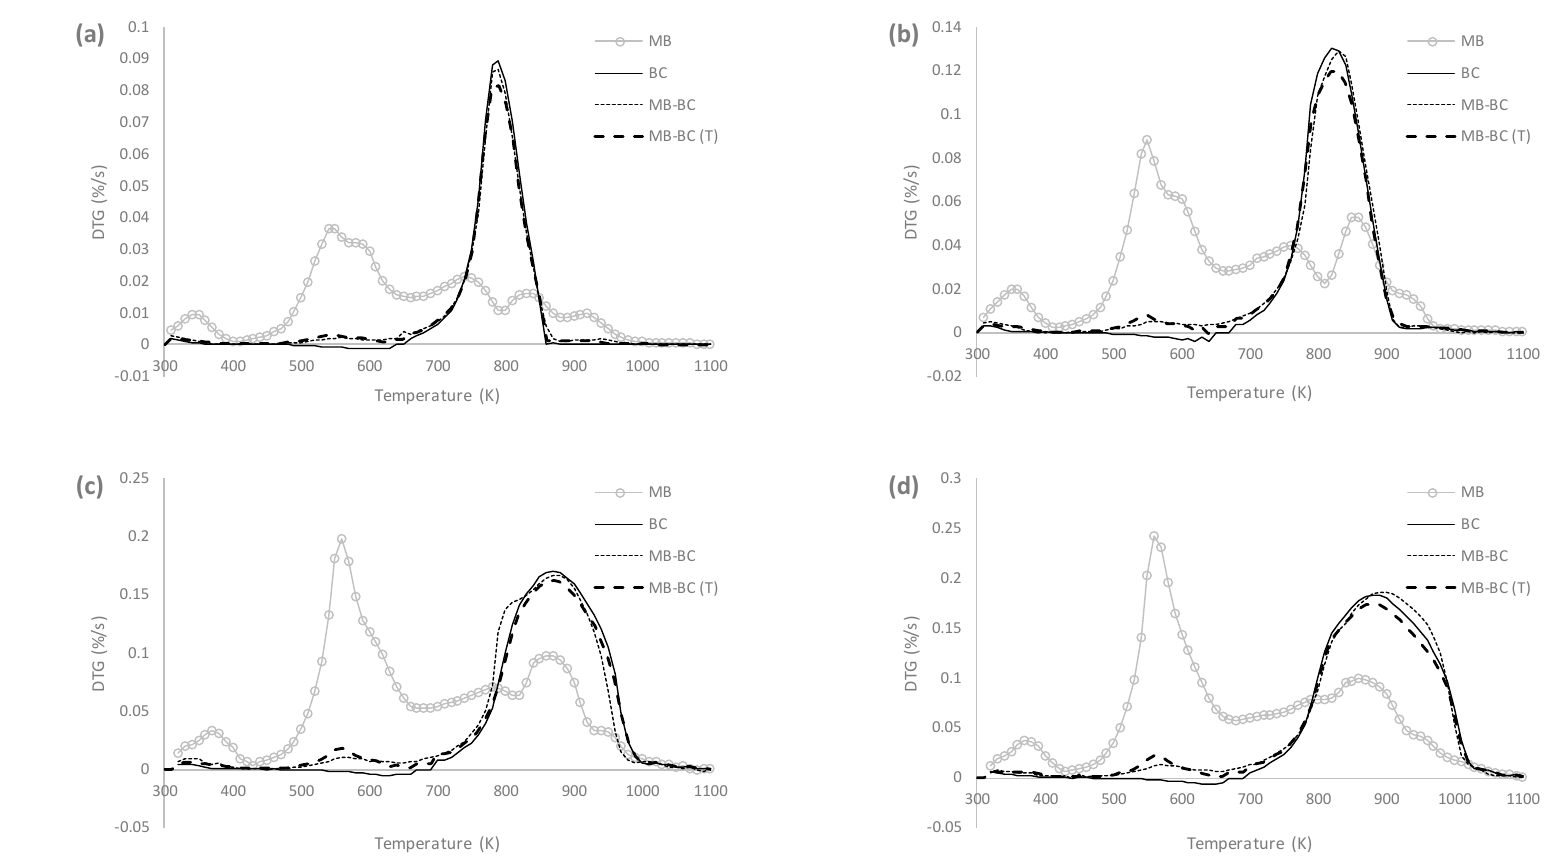
Figure 2. Di ff erential thermogravimetry (DTG) curves corresponding to the temperature programmed combustion of MB, BC and their blend (MB-BC) together with the weighted calculated curve corresponding to the blend (MB-BC (T)) at the di ff erent heating rates here used, namely 0.1 K / s ( a ), 0.2 K / s ( b ), 0.4 K / s ( c ), and 0.5 K / s ( d ).